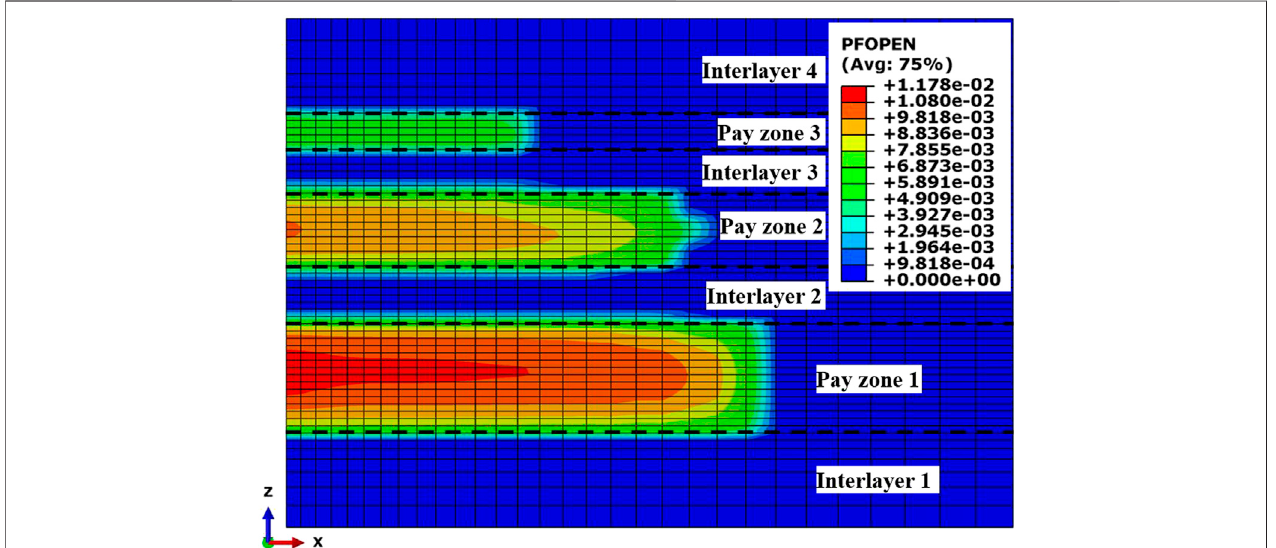
FIGURE 8 | Hydraulic fracture geometries in the model containing seven